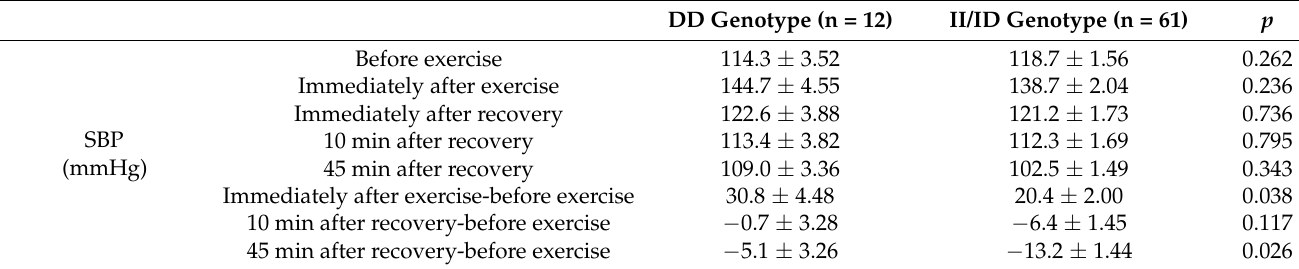
Table 3. Comparison of BP for different genotypes during HIIJ